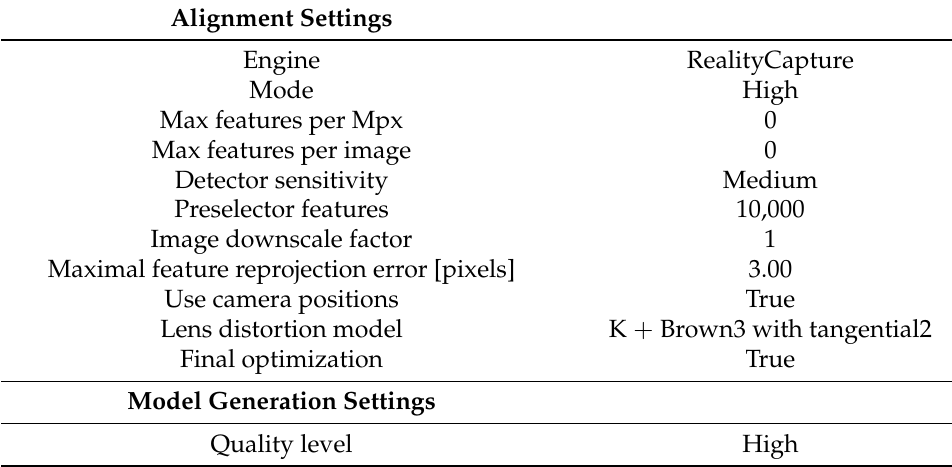
Table 4. RealityCapture image alignment and processing